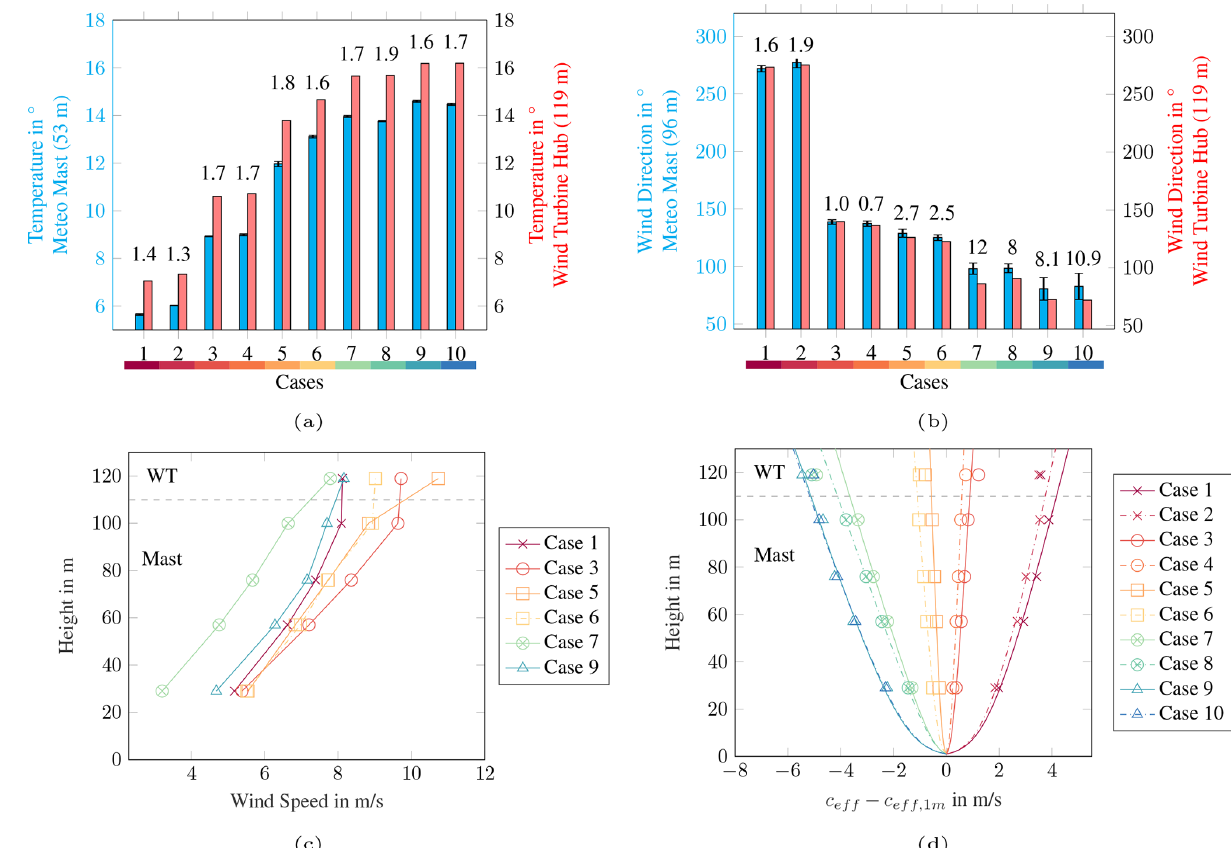
Figure 14. Comparison of atmospheric data measured at the 100m mast and at the wind turbine (119m). (a) Temperature measured at 53m on the meteorological mast and at the wind turbine hub (119m). (b) Wind direction measured at 96m on the meteorological mast and at the wind turbine hub (119m). In panels (a) and (b) , the differences between the data are written above the bar, and the standard deviations are given for the mast measurements. (c) Wind speed measured at various heights on the meteorological mast and at the wind turbine hub (119m). (d) Profiles of effective sound speed (lines) based on measured data (markers), normalised with the effective sound speed at 1m.